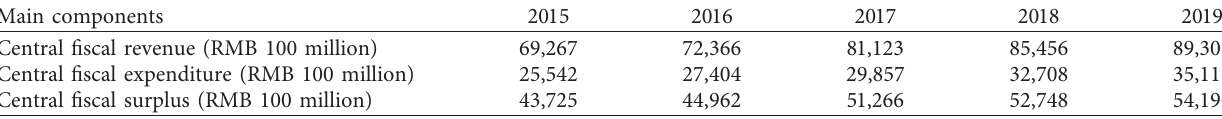
Table 4: Central government revenue and expenditure (2015–2019).